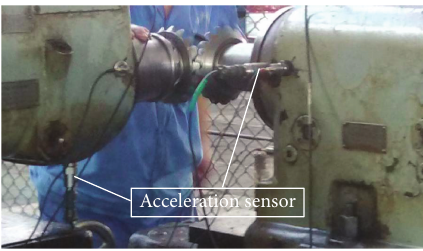
Figure 2: Layout of acceleration sensors in the experimental stage.